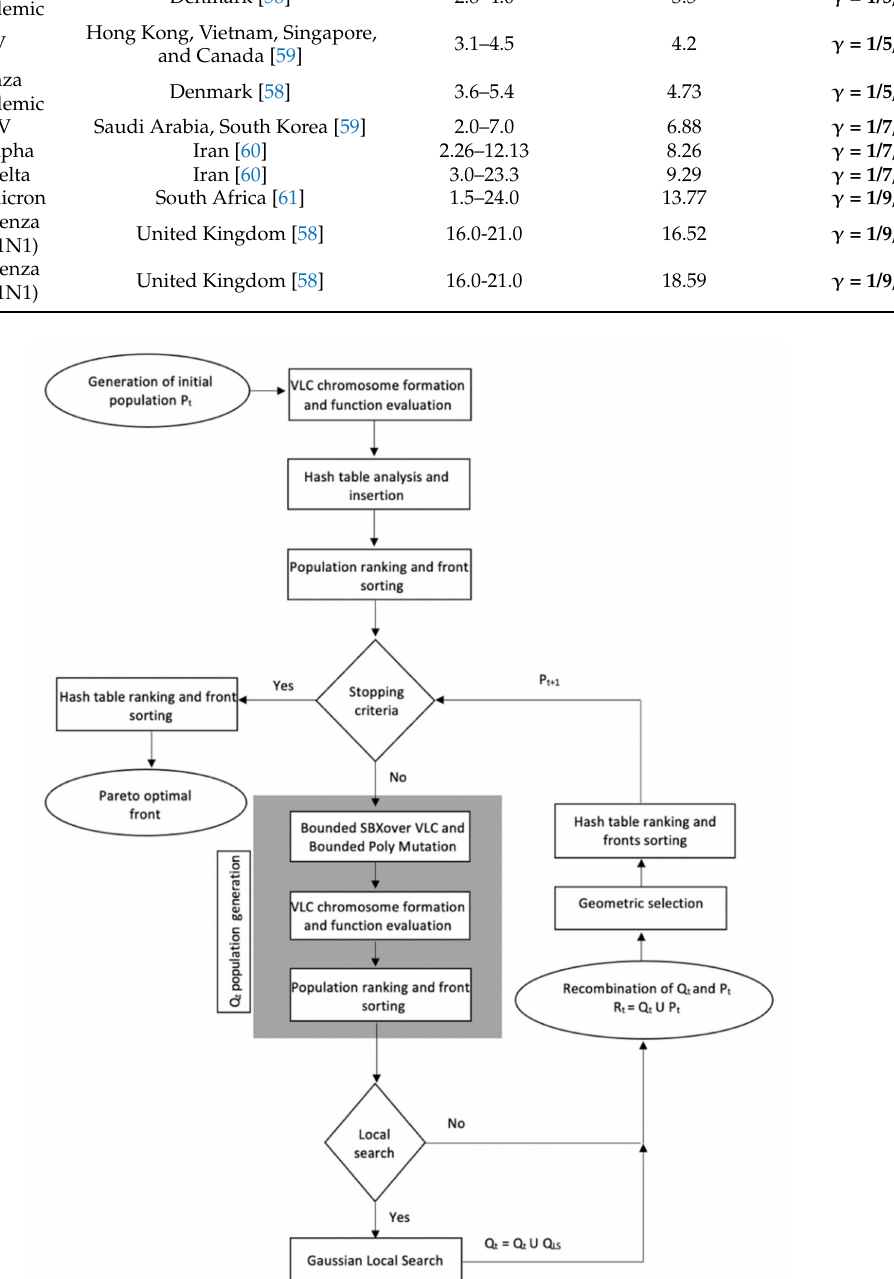
Figure A1. Flowchart of the CENSGA